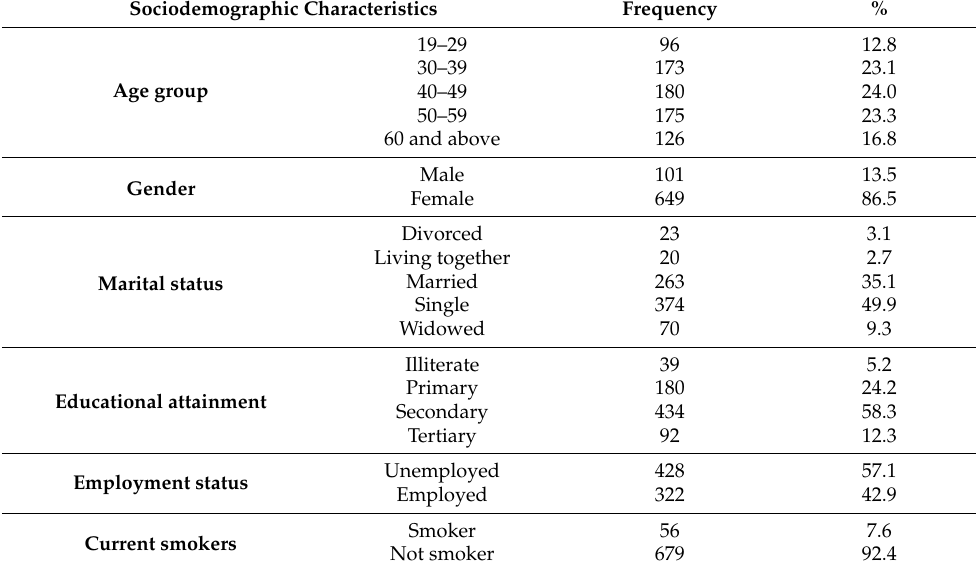
Table 1. Sociodemographic characteristics of the study